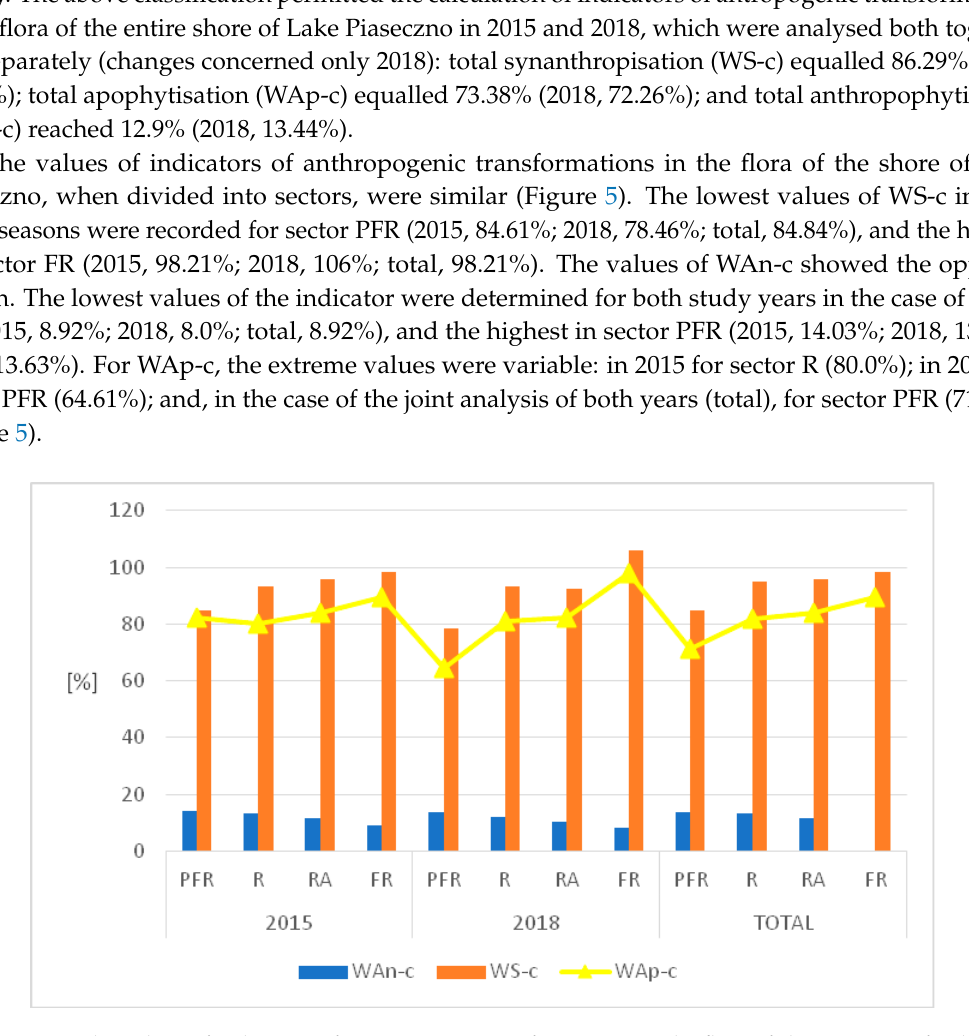
Table 6. The percentage shares of plant species with different habitat requirements in the flora (based on Zarzycki et al. 2002 [42]) of the study area in 2015 and 2018 (extreme values are marked with colours: yellow, min; orange, max).